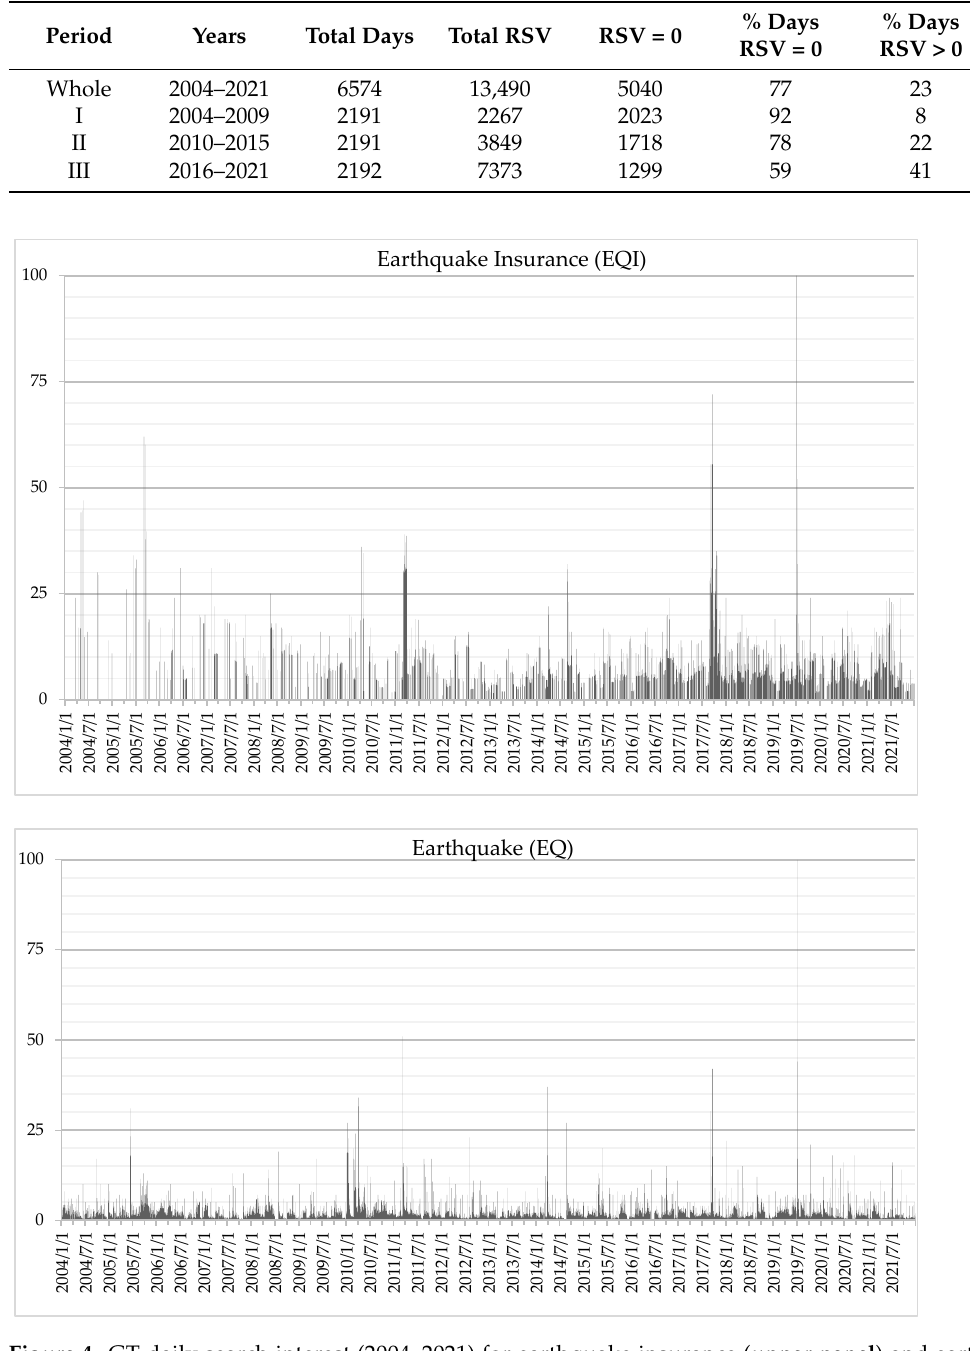
Table 2. Spearman rank correlation and Pearson linear correlation between ( 1 ) GT earthquake